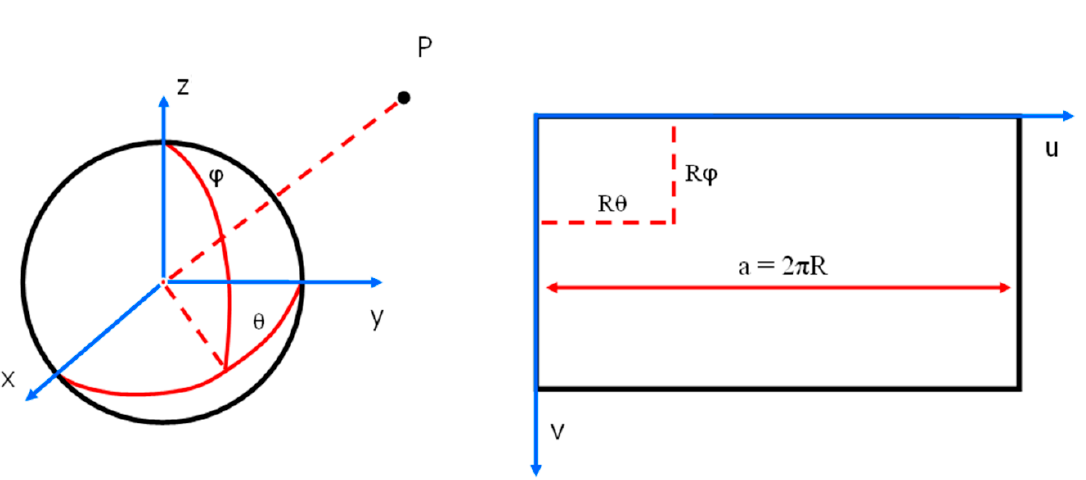
Figure 2. The geometry of a spherical image converted into an equirectangular projection. The only calibration parameter is the focal length, see Fangi (2015) [15].